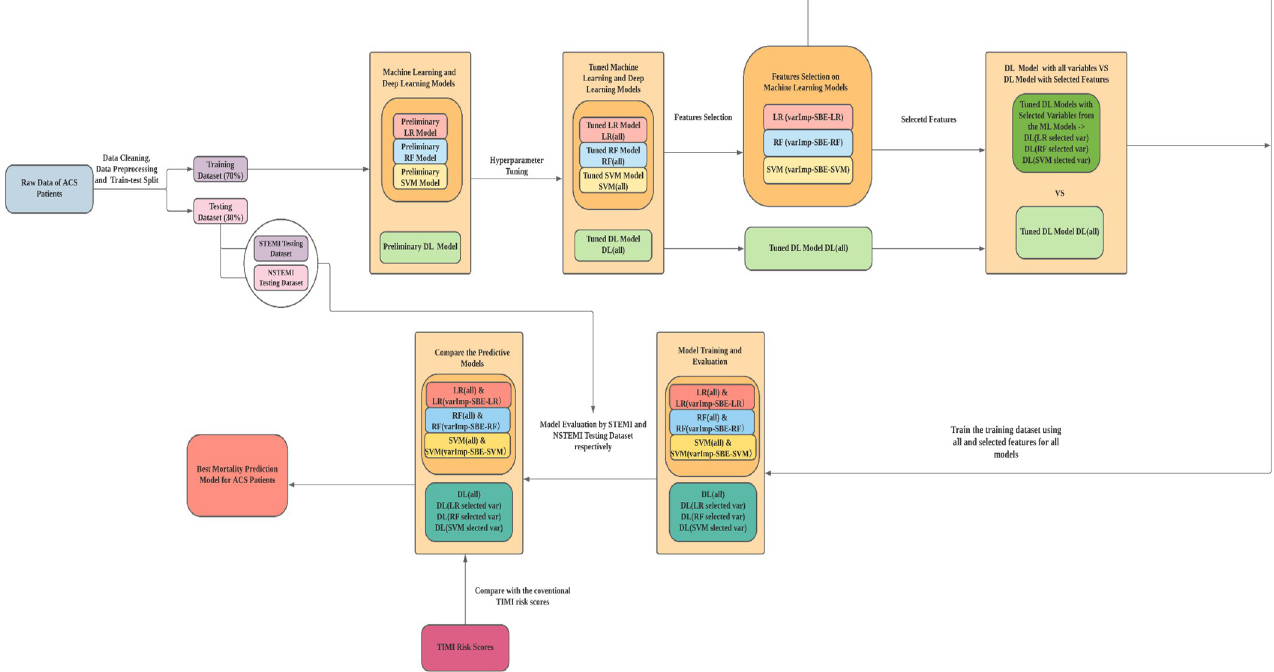
Fig 2. Flowchart of the predictive models’